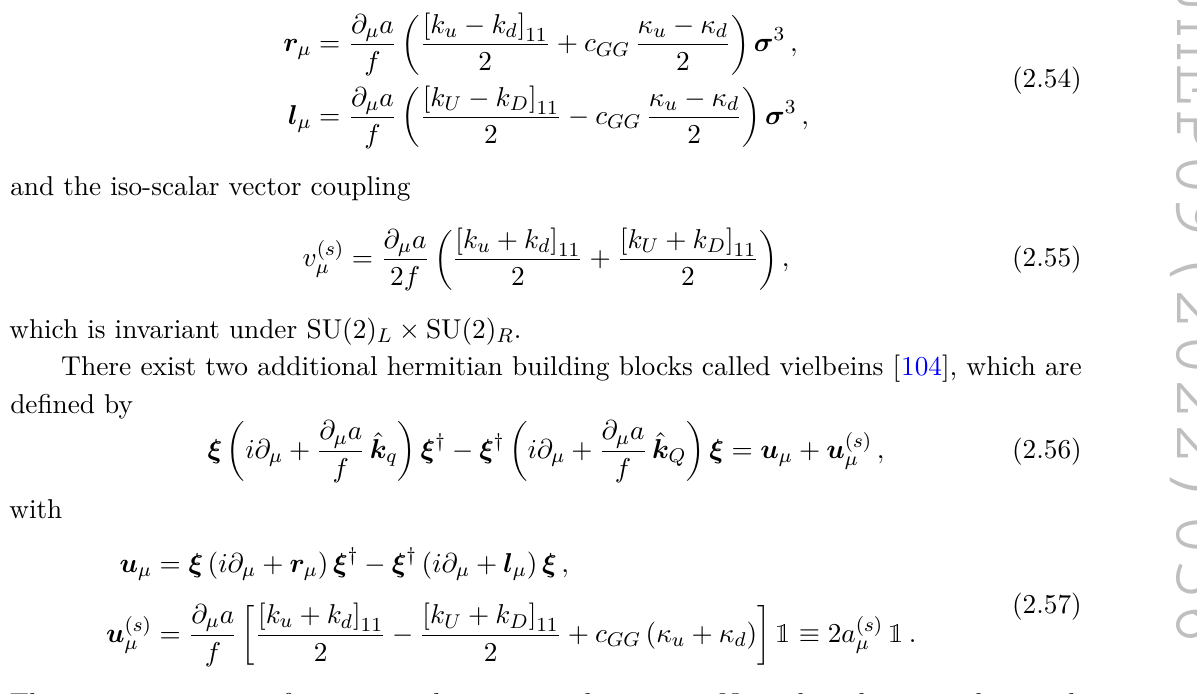
ˆ ) and ˆ k , k u d